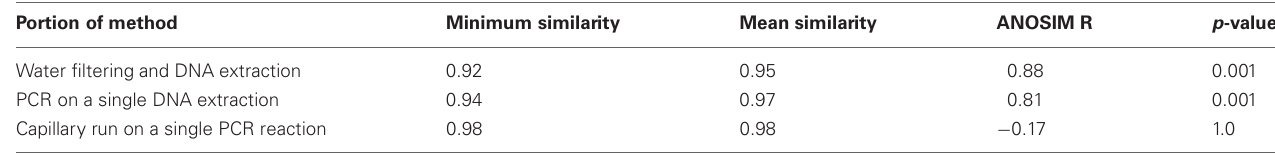
Table 3 | Minimum and mean Sørensen’s similarity of replicate profiles at three major steps of the ARISA procedure. Portion of